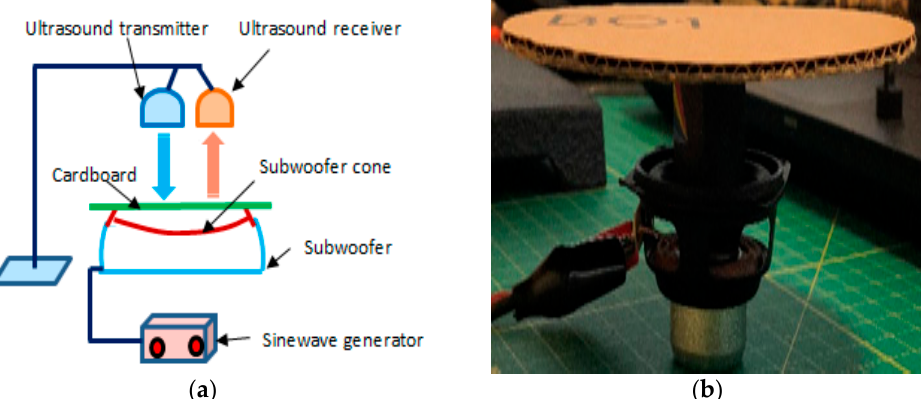
Figure 1. ( a ) A schematic diagram of the set-up used to simulate chest movement, ( b ) modified subwoofer connected to a signal generator used to simulate chest movement.